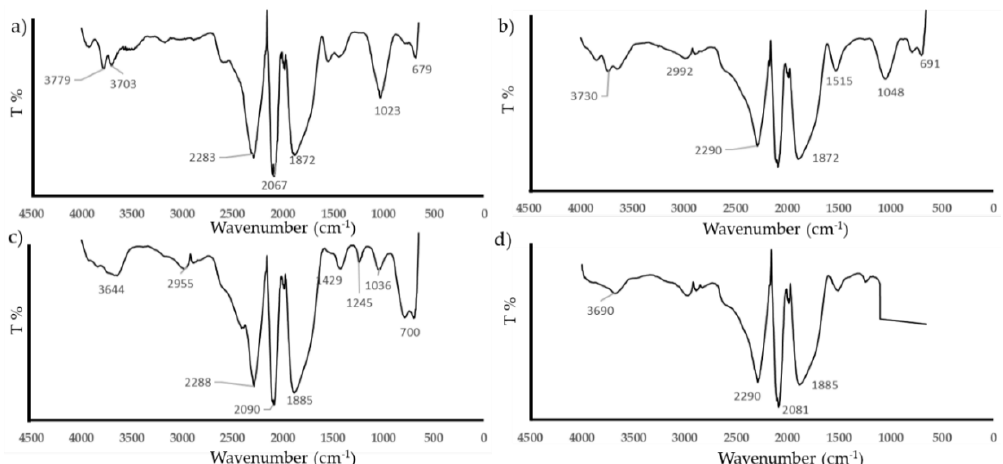
Figure 5. FTIR spectra for chemically treated rubber wood derived biochar: ( a ) post alkali RW, ( b ) post acid RW, ( c ) pre-treated alkali RW, ( d ) pre-treated acid RW.